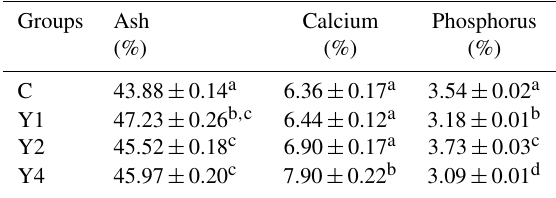
Table 3. Effects of Saccharomyces cerevisiae on broiler tibiotarsus ash, calcium and phosphorus